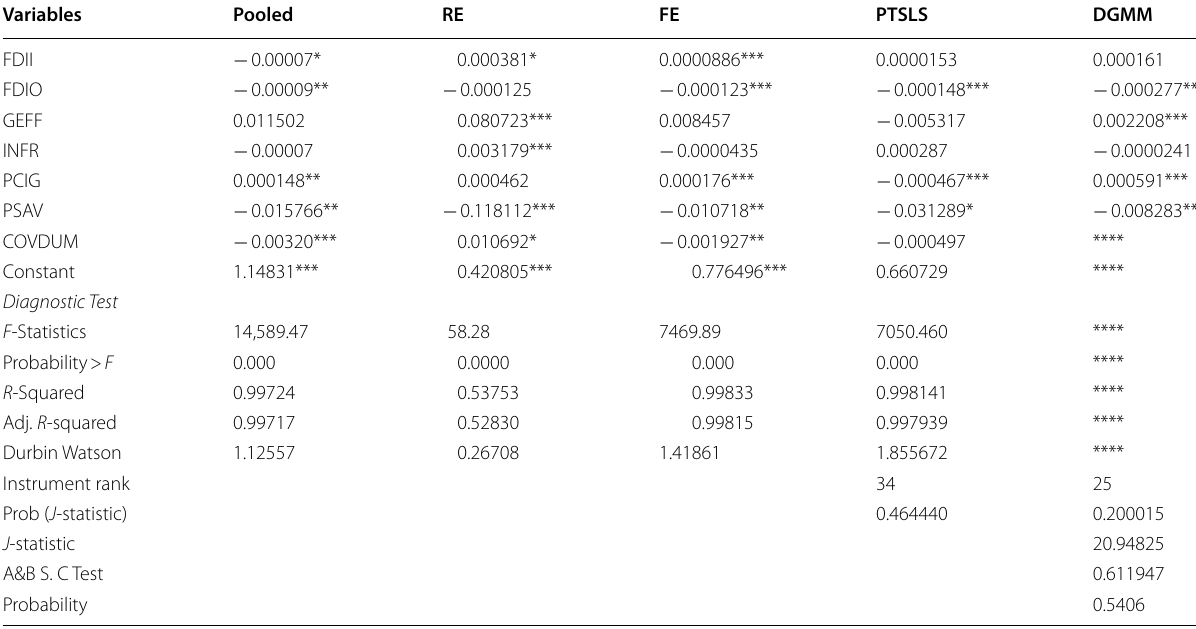
*, **, ***Denote significance level at 10%, 5% and 1% while ****indicates Not Applicable